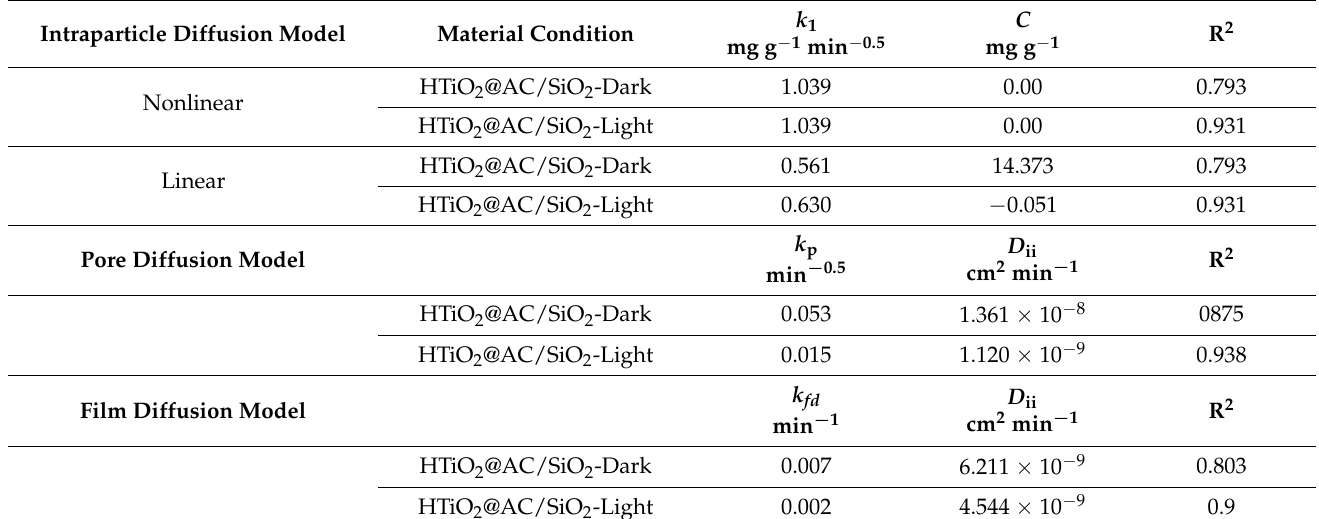
Table 3. Diffusion